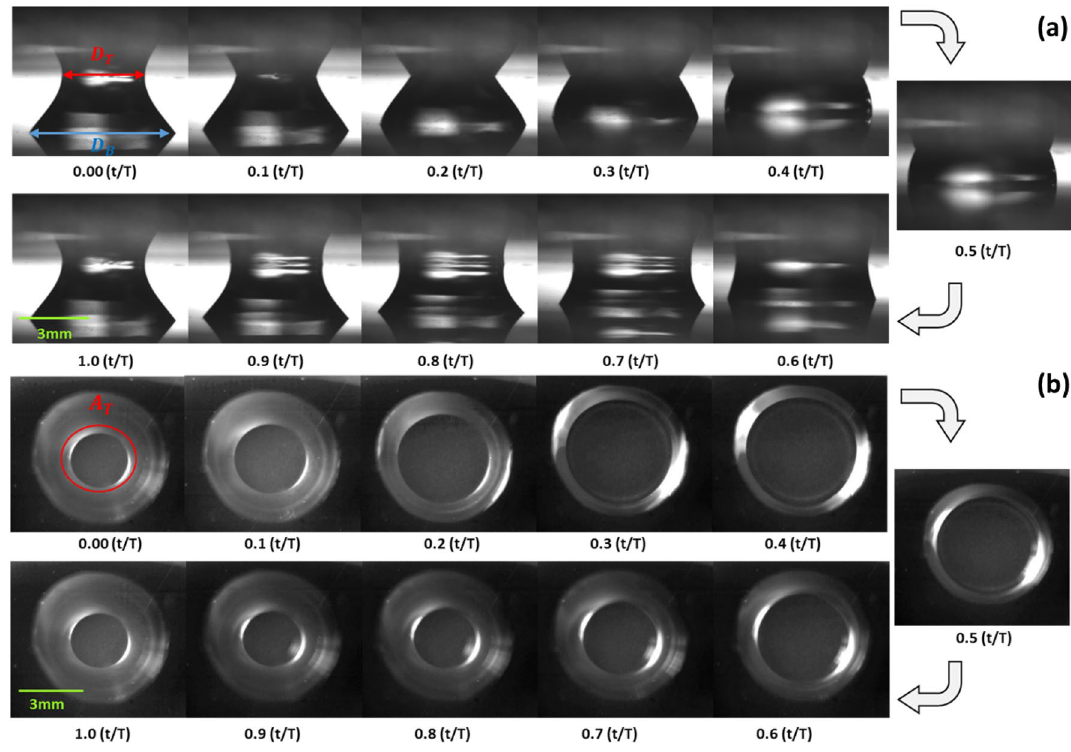
Figure 2. ( a ) Front view and ( b ) top view of an oscillating liquid bridge between hydrohpobic (top side) and hydrophilic (bottom side) surfaces at a frequency of 10 Hz and vibration amplitude of 0.50